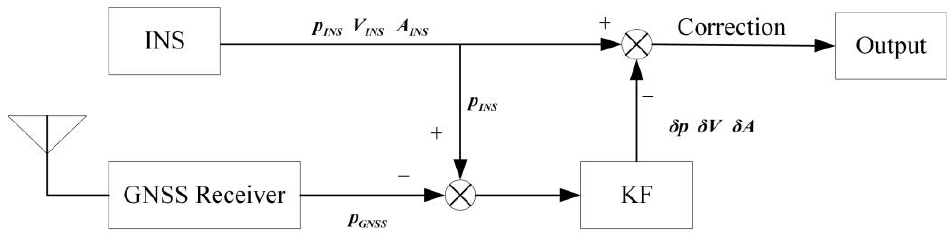
Figure 1. Traditional GNSS/INS loose coupling navigation system.